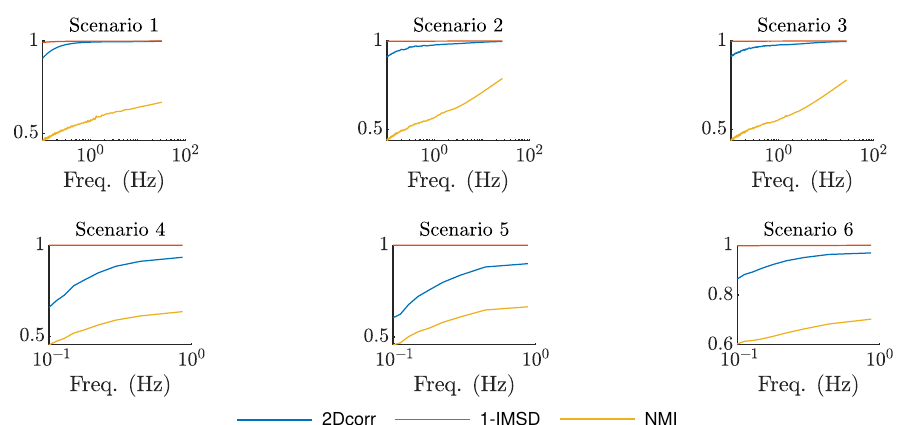
Figure 10. Metric response to video recording frequency. Displayed values show similarity between two stable consecutive frames, time-averaged along each video sequence. 1-IMSD is displayed for consistency with the rest of metrics.